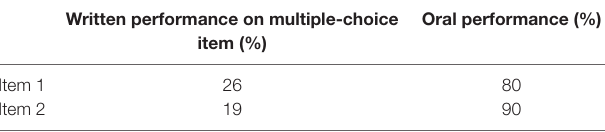
Table 1 | Proportions of correct answers to the same items. Written performance on multiple-choice item